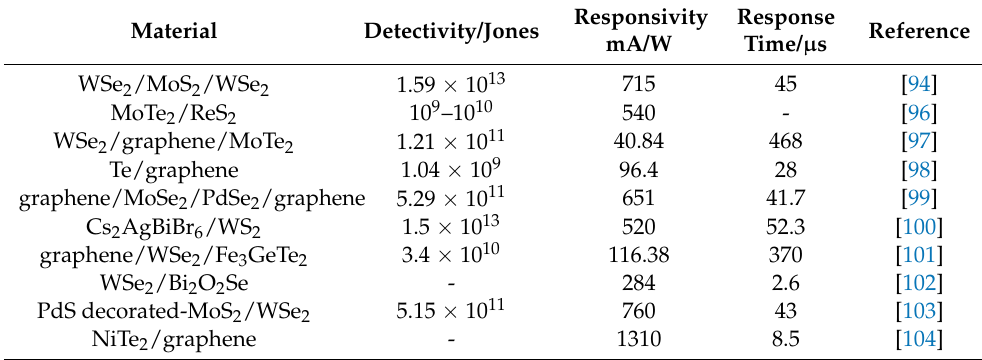
Figure 8. Cross-sectional diagram of energy band gap and charge transfer under the illumination state. Adapted with permission from [94]. Copyright © 2021, American Chemical Society. Table 2. Performance of photodetectors of 2D